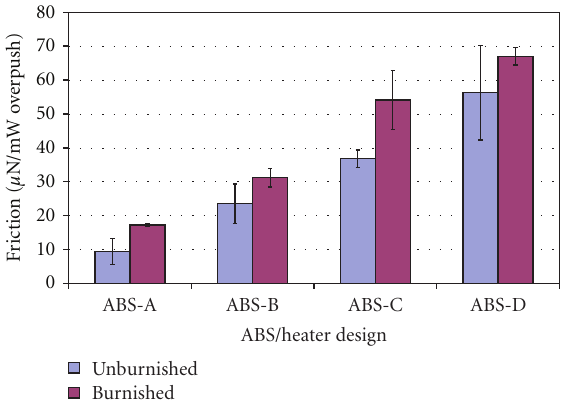
Figure 13: E ff ect of TFC e ffi ciency (ABS/heater design) on friction.